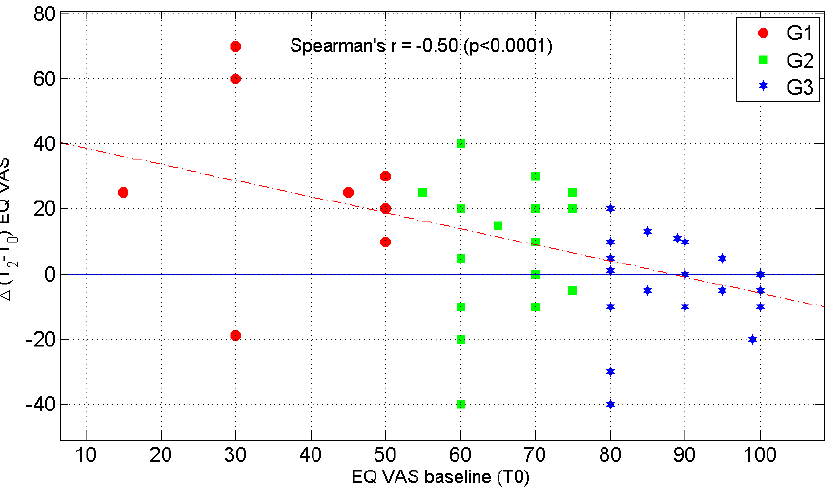
Figure 2. Association between Δ(T2 − T0) EQ VAS and baseline EQ-VAS (T0) according to sample stratification at T0 G1: EQ- VAS ≤ 50; G2: 50 < EQ - VAS ≤ 75; G3: EQ -VAS >